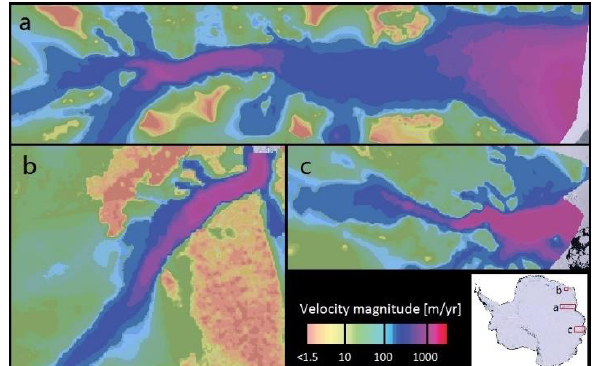
Figure 1. Ice velocity mapping results of selected glaciers from 1960s to the 1980s. (a) Amery Ice Shelf, (b) Rayner Glacier, and (c) Shackleton Ice